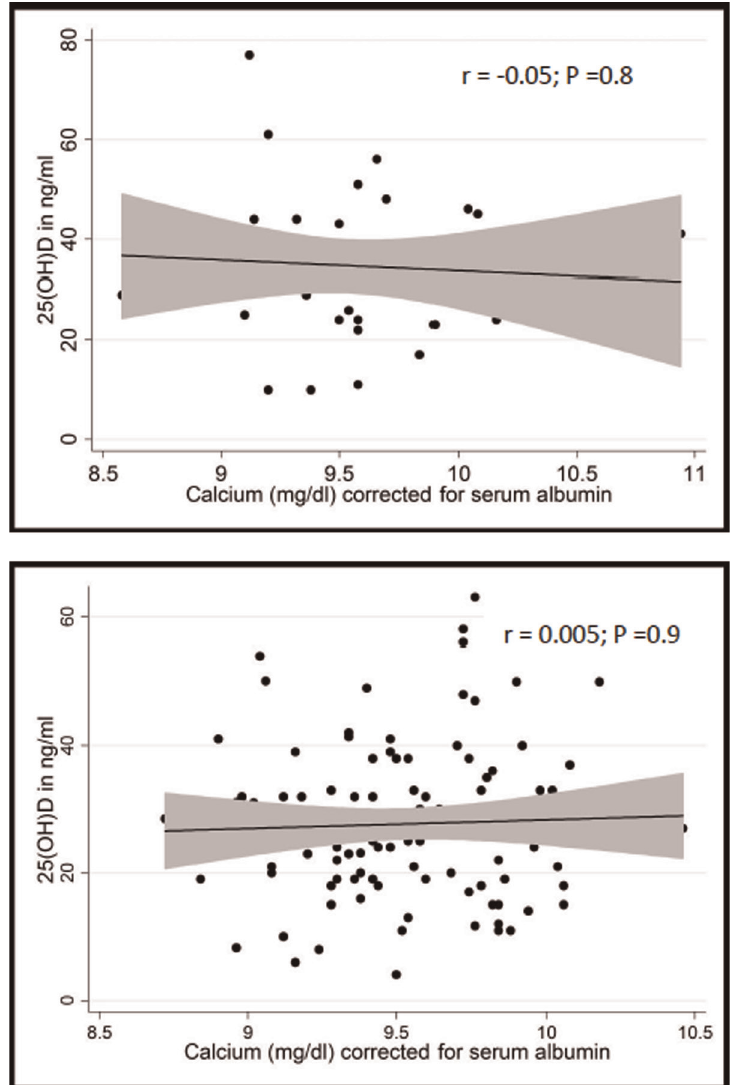
Figure 2. Scatterplot of relationship of serum 25-hydroxyvitamin D [25(OH)D] and serum-corrected calcium in patients receiving both vitamin D and calcium supplementation (n = 37) (top) and in patients not receiving vitamin D or calcium supplementation (n = 109)